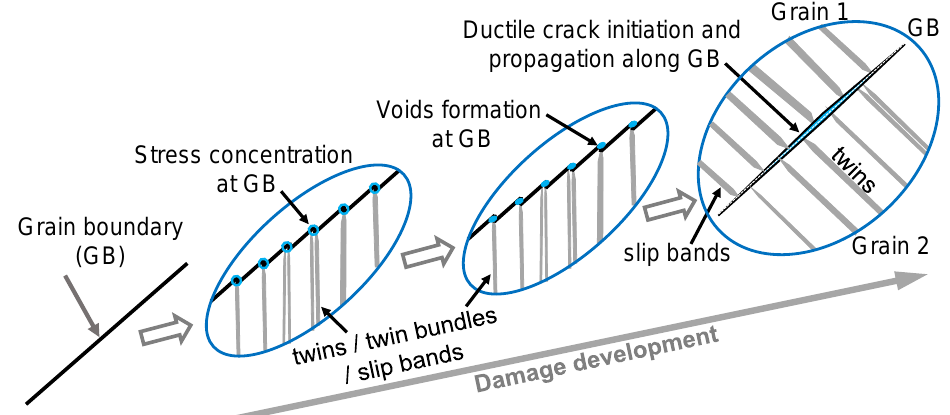
Figure 14. A schematic illustration of micro-cracking mechanisms in TWIP steels based on the experimental observations from interrupted micro-tensile tests carried out in the SEM. Stress concentration caused by the intercepting deformation twins at GB. Void formation and their growth leading to inter-granular micro-crack initiation at